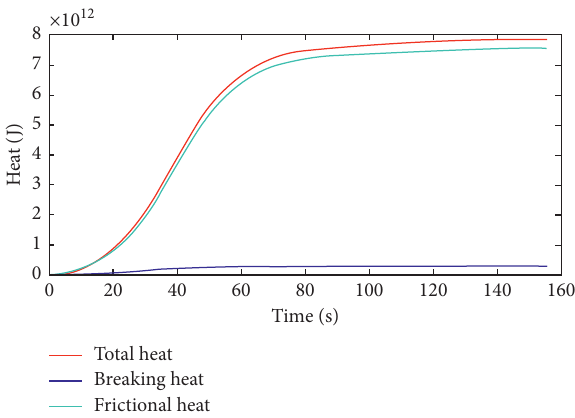
Figure 10: Heat change curve of the landslide